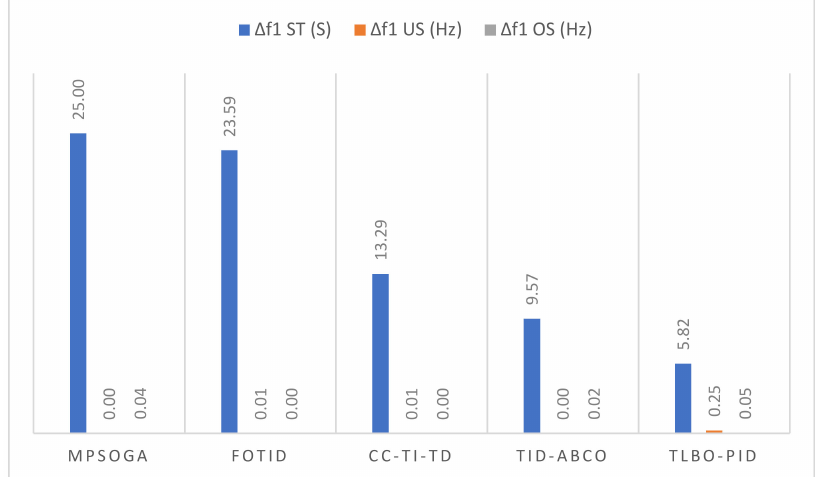
Figure 14. Frequency Deviation for Interconnected